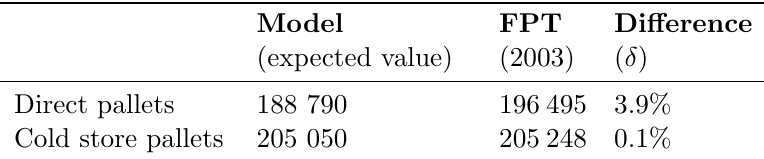
Table 3: Comparison of parameter “Number of pallets received” at FPT for